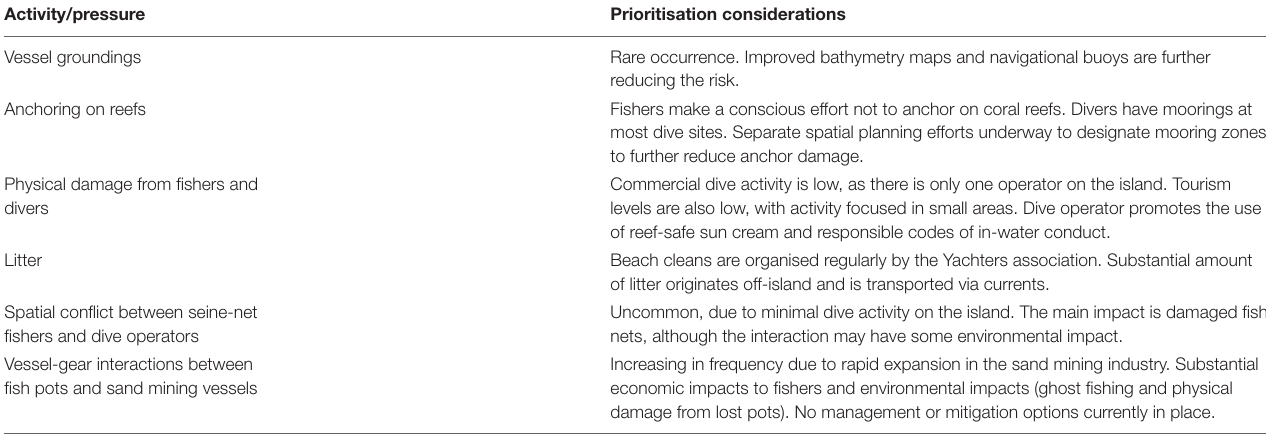
TABLE 1 | Outcomes from stakeholder activities and pressures prioritisation